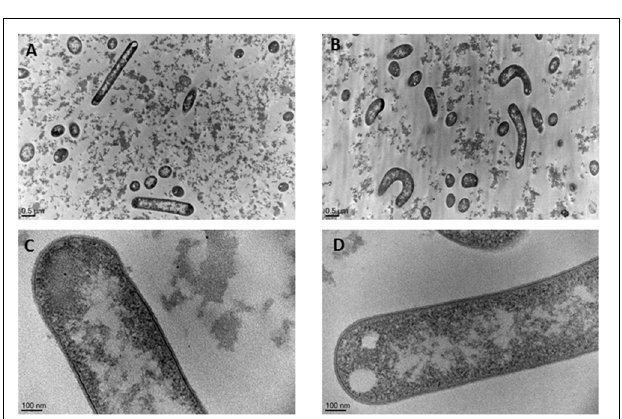
FIGURE 3 | Hyperconcentrated sweet whey triggers morphological rearrangements in L. casei BL23. Lactobacilli were cultivated 48 h in isotonic 5% (A,C) or hyperconcentrated 30% (B,D) sweet whey. They were then fixed, stained, and ultrathin sections were observed using transmission electron microscopy. The bacterial cell diameter and cell wall thickness were then quantified. Cells with clear edge were selected for the measurement.